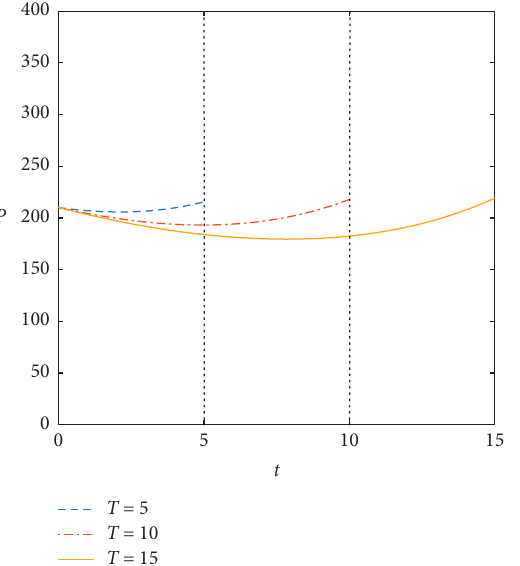
Figure 21: Trajectory curve of optimal pollution stock under non- cooperation when the planning period T � 5 , T � 10, and T � 15.